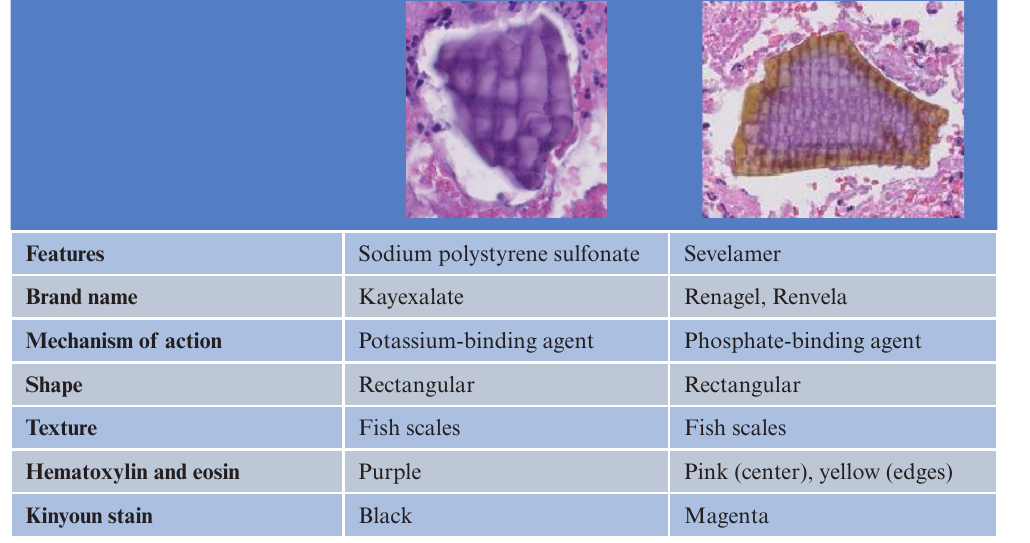
Source: Adapted from Gonzalez